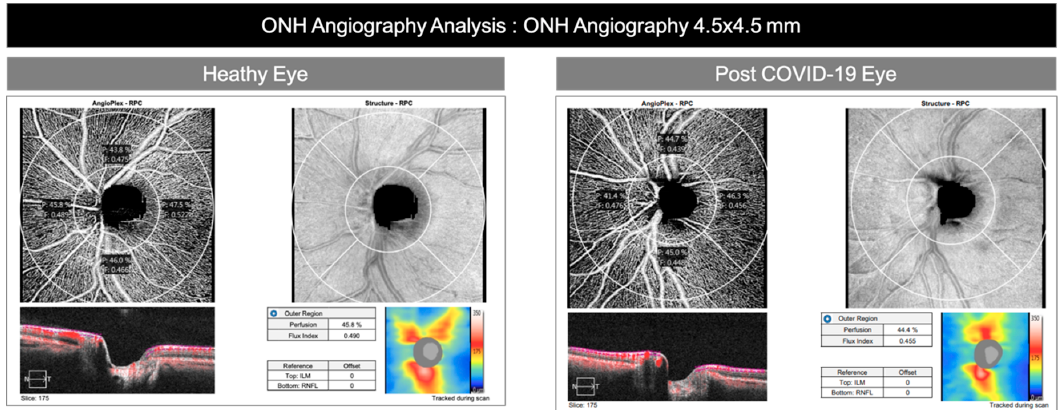
Figure 2. Healthy and post-COVID-19 eyes. Angioanalysis of optic nerve head analysis (ONH = optic nerve head Angiography, 4.5 × 4.5 mm). Lower RPCP-PD value in post-COVID-19 eyes compared to the healthy group ( p < 0.04) was observed.